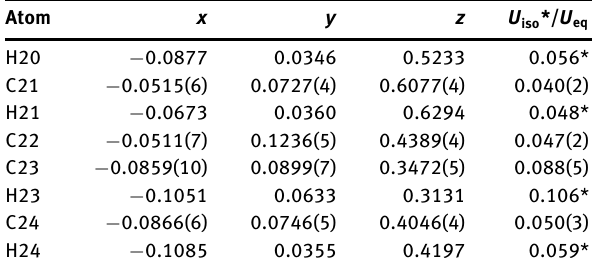
Table 2: Fractional atomic coordinates and isotropic or equivalent isotropic displacement parameters (Å 2